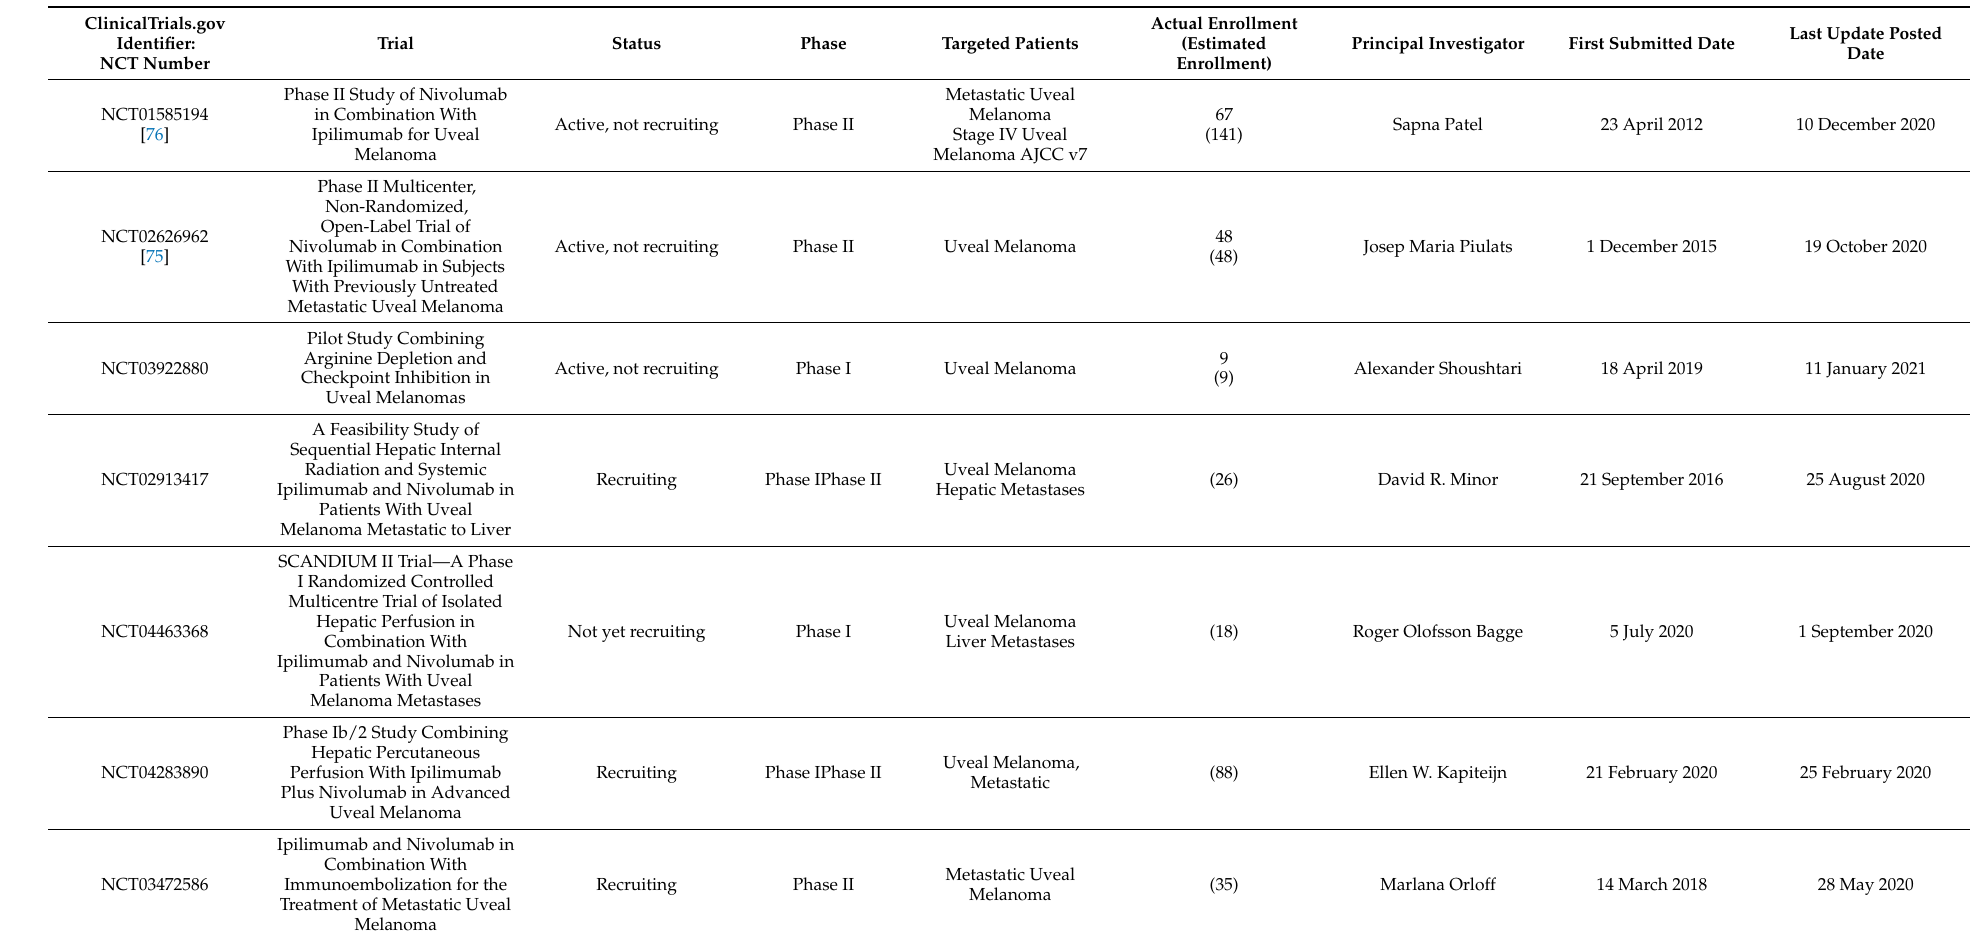
Table 3. Combination immunotherapies in